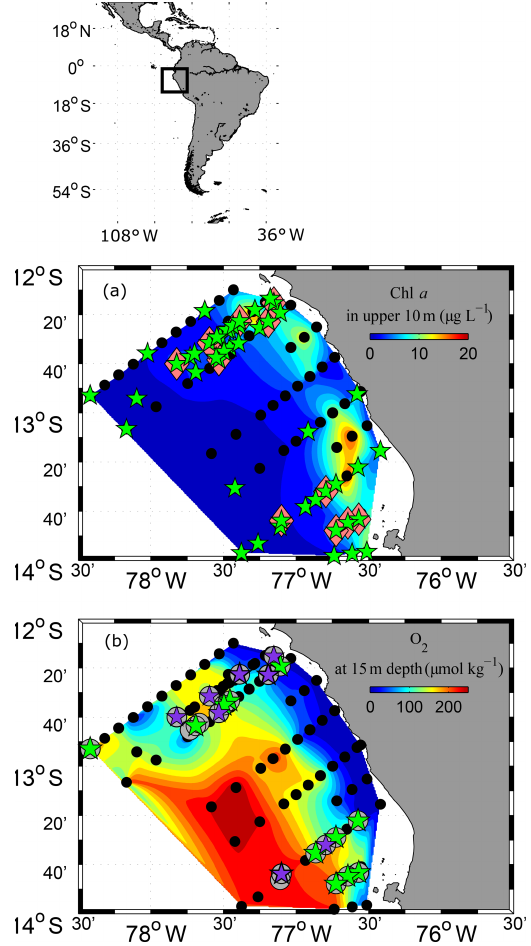
Figure 1. Study area and station map. CTD stations where CTD- probe and fluorimeter measurements were performed are marked as black dots (a, b) . PUMP-CTD stations are depicted in pink diamonds (a) . CTD and PUMP-CTD stations where DOM sam- pling was performed are marked as green stars (a) . Microstruc- ture measurements combined with oxygen profiles are marked as grey circles (b) . Microstructure measurements, combined with dissolved organic matter (dissolved organic carbon (DOC), dis- solved hydrolysable amino acids (DHAA) and dissolved com- bined carbohydrates (DCCHO)) measurements, are marked as green pentagrams (b) . Extra microstructure measurements, com- bined with DOC measurements, are marked with violet penta- grams (b) . Shaded colours represent chl a concentrations at upper 10m depth (a) and oxygen concentrations at 15m depth (b) . Spaces between data points were interpolated by using the TriScatteredIn- terp function (MATLAB,